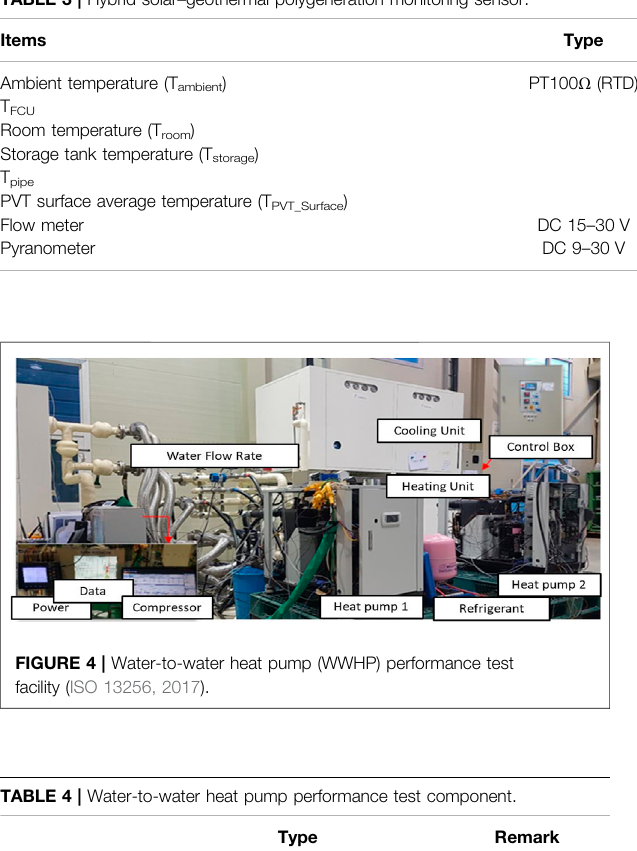
TABLE 3 | Hybrid solar – geothermal polygeneration monitoring sensor.